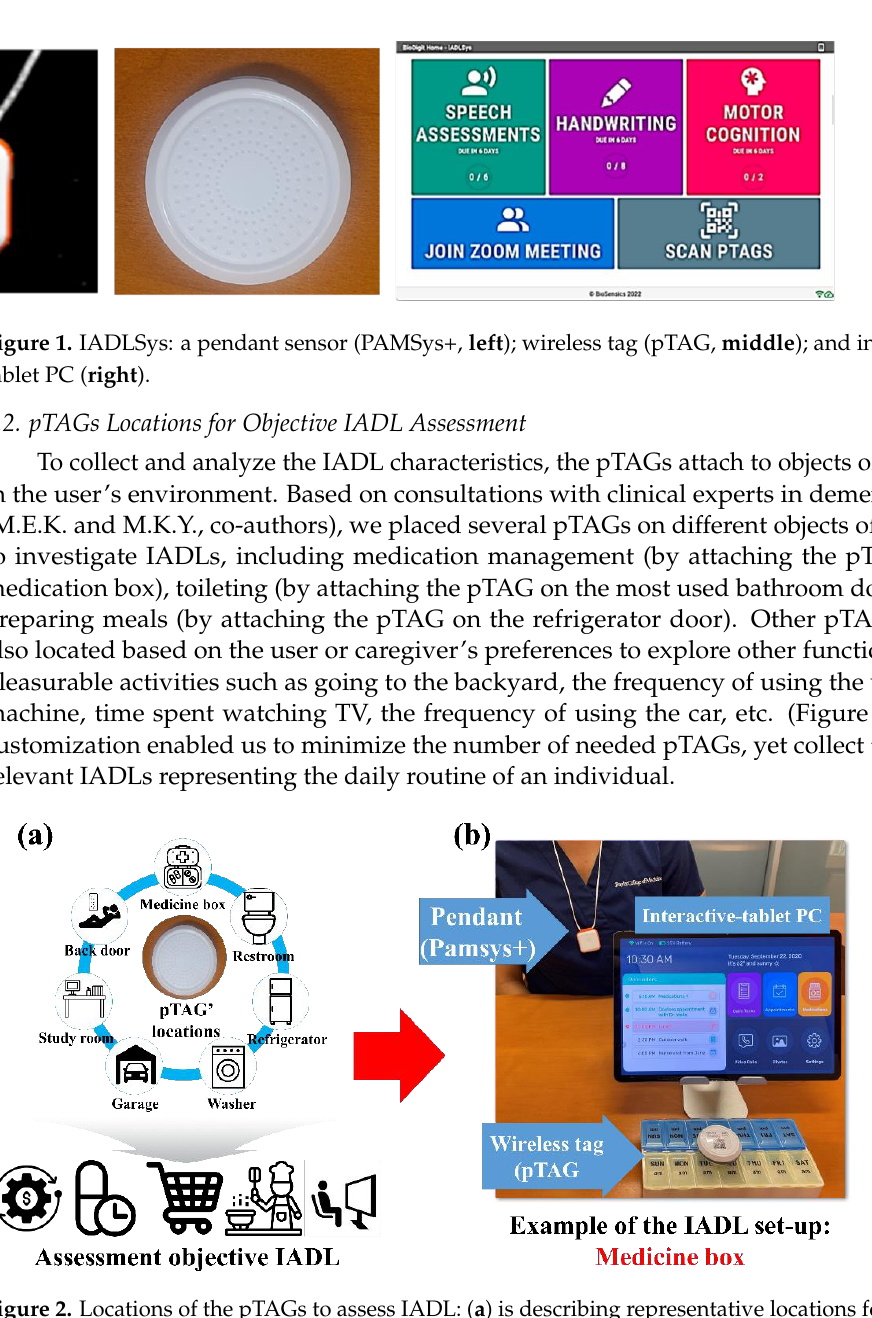
Figure 3. Data acquisition using the IADLSys. 2.4. Data Analysis for the Objective IADL Derived from the IADLSys The recorded interaction event from the IADLSys can provide raw data via a Mi- crosoft Excel file. The raw data includes several variables such as recorded time (Unix time format), the activated sensor’s ID, movement duration , 3-axis accelerometer (x, y, and z), and received signal strength indication (RSSI). RSSI reflects proximity between pTAG and pendant and is built using several factors from the PAMSys+ pendant (i.e., physical activity patterns) and pTAG signal strength (magnitude and difference). The fre- quency of the interactions was considered to investigate how many times the individual interacts with the objects of interest over a continuous 7 days. The recorded time value